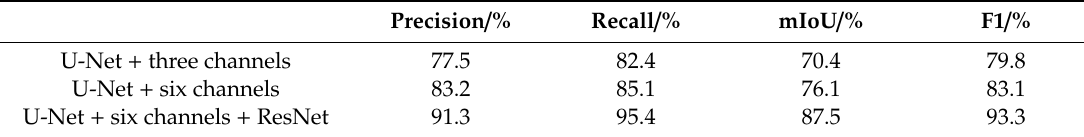
Table 2. Comparison between traditional U-Net and improved